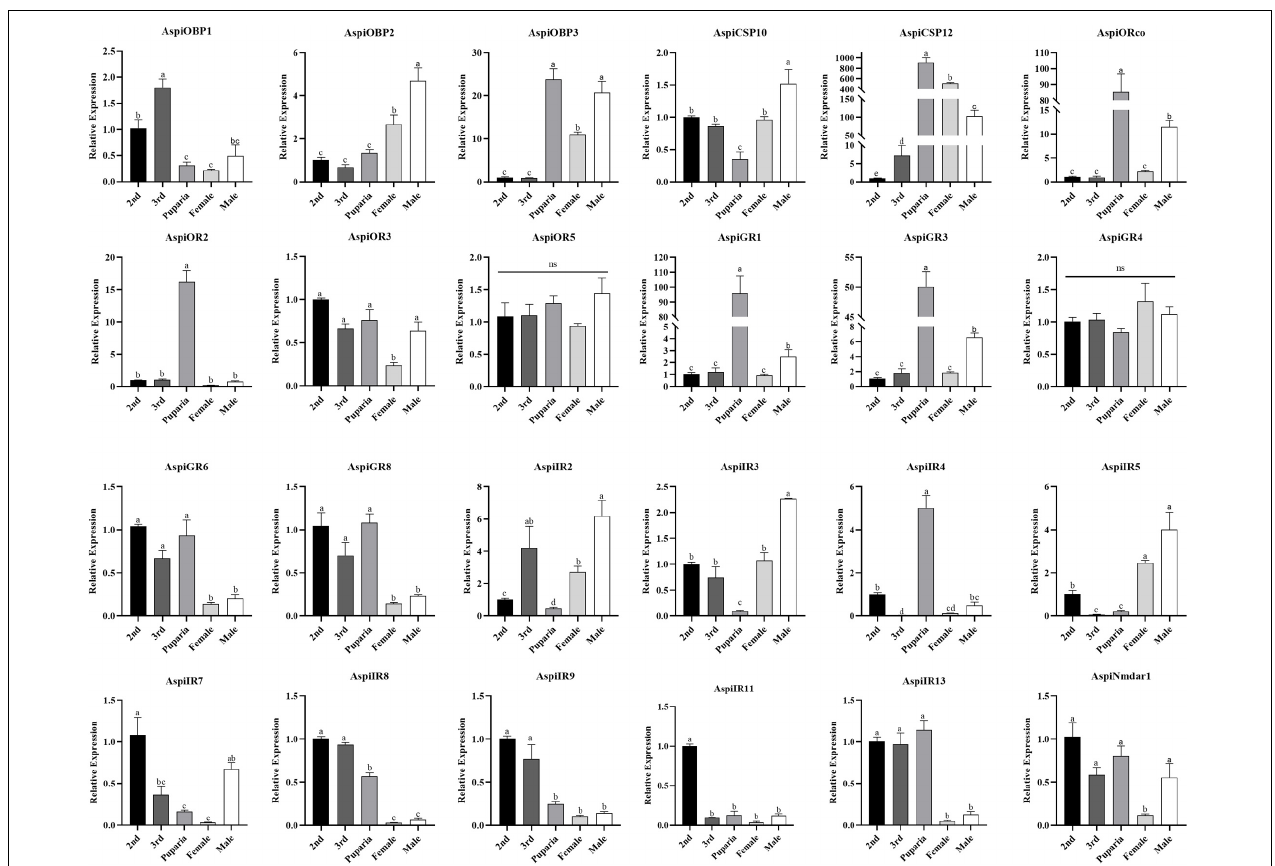
FIGURE 8 | Quantitative real-time polymerase chain reaction (qPCR)-based expression profiling of selected chemosensory genes in different developmental stages of A. spiniferus .